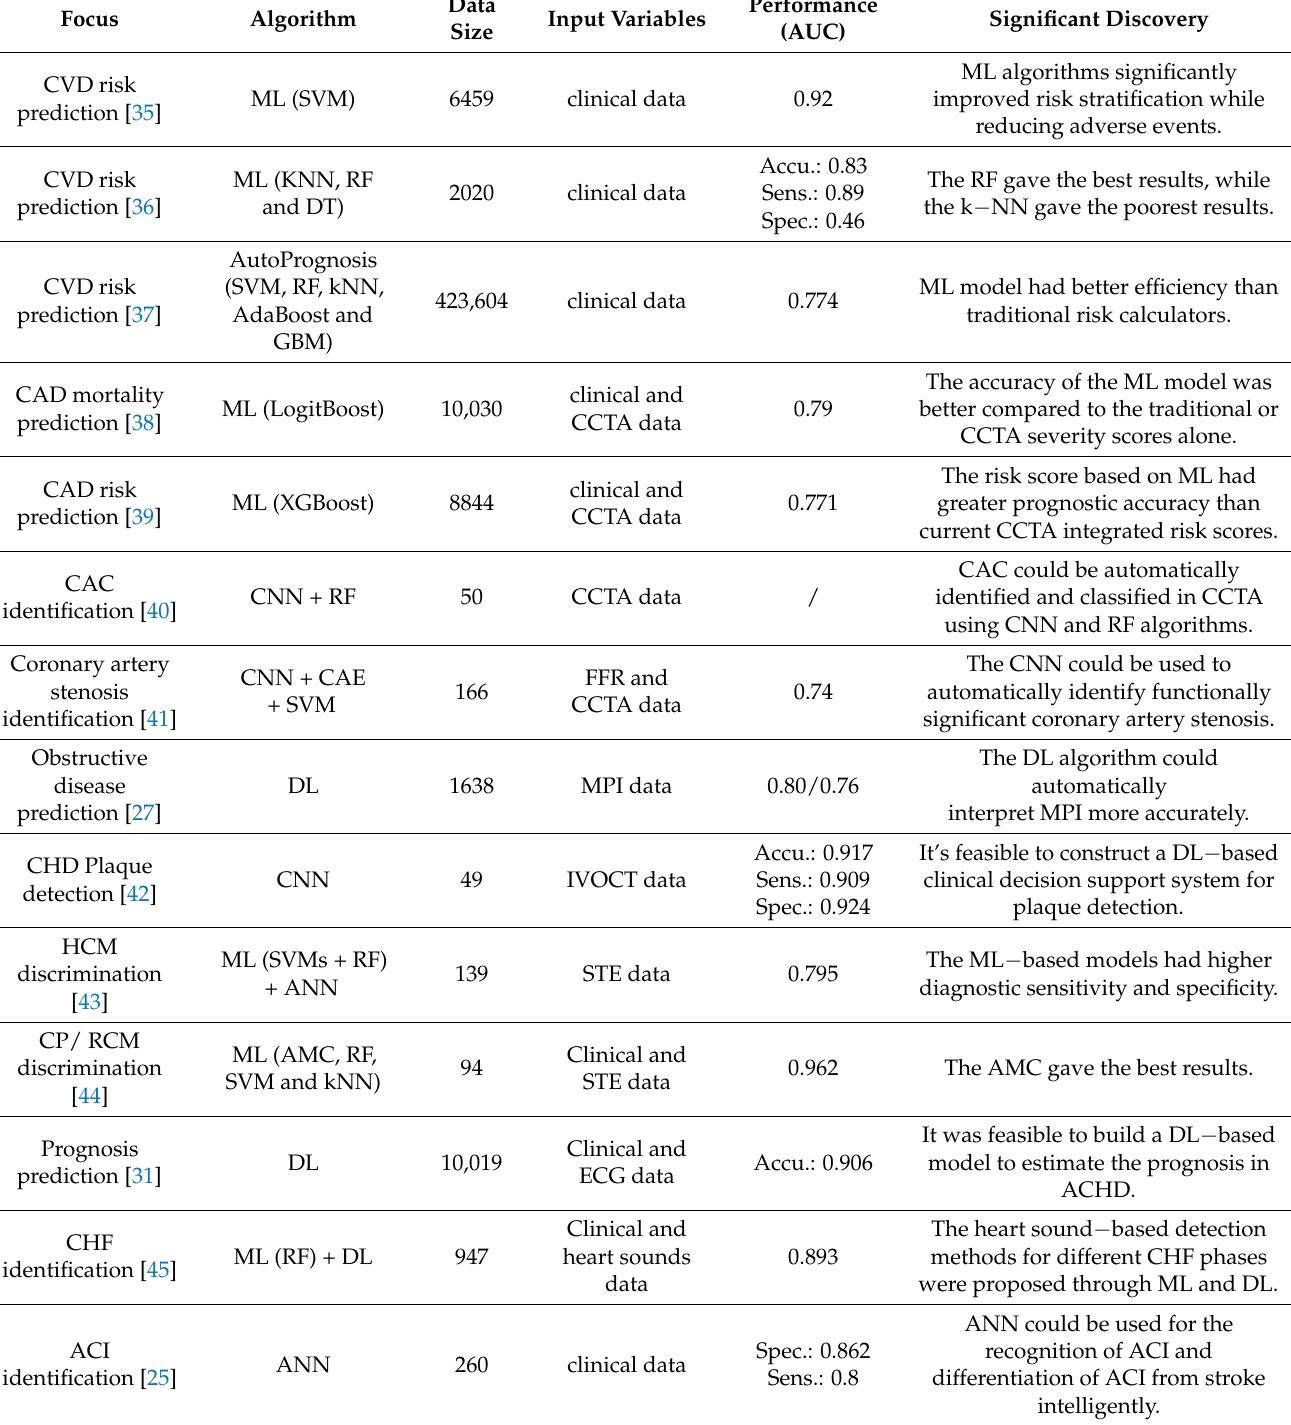
Table 1. Machine learning − based prediction models of cardiovascular